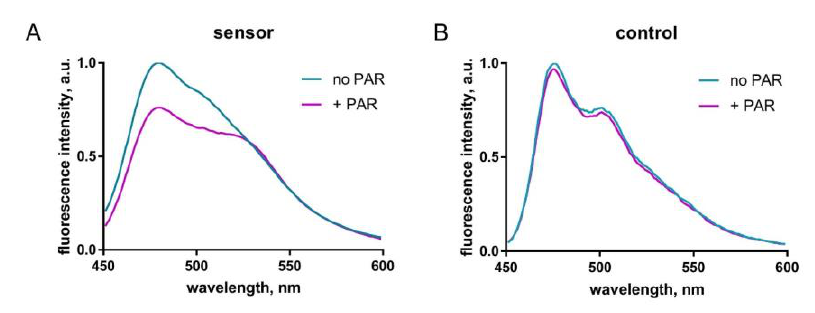
Figure 3. FRET increase after addition of synthetic PAR to the purified sPARroW in solution. ( A ) sPARroW emission spectra before and after addition of PAR. ( B ) Control emission spectra of mixed donor and acceptor without the WWE domain (negative control) before and after addition of